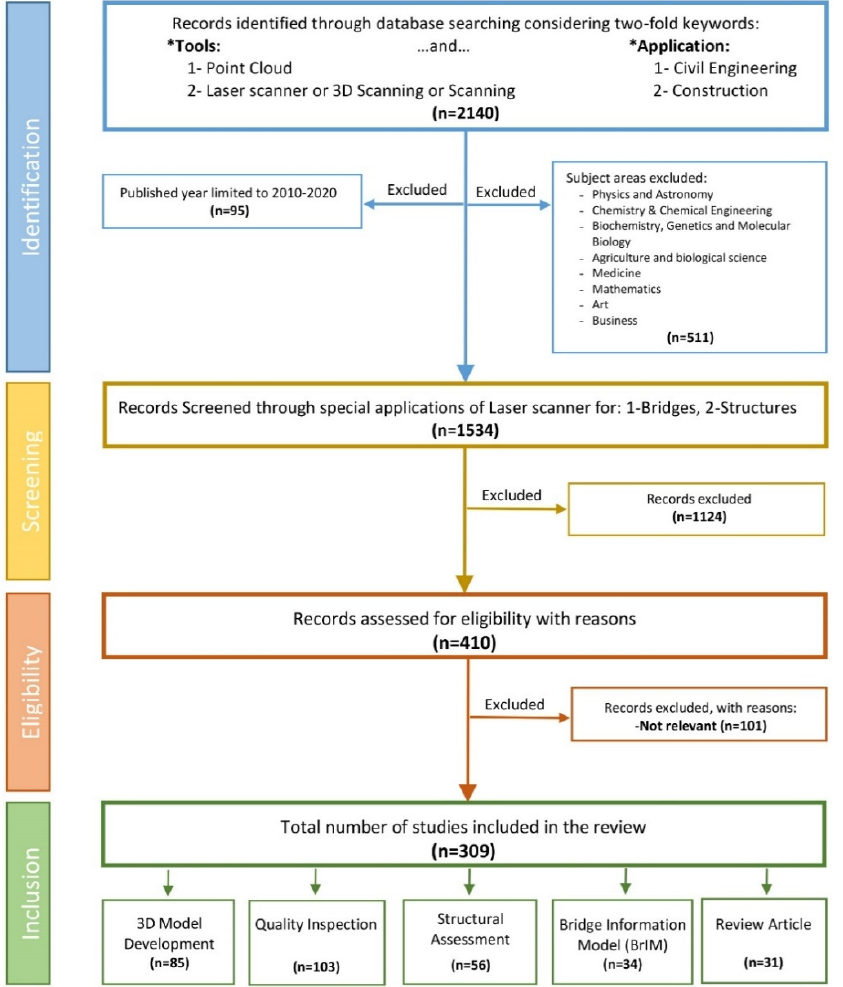
Figure 1. Flowchart of the scientometric review process.